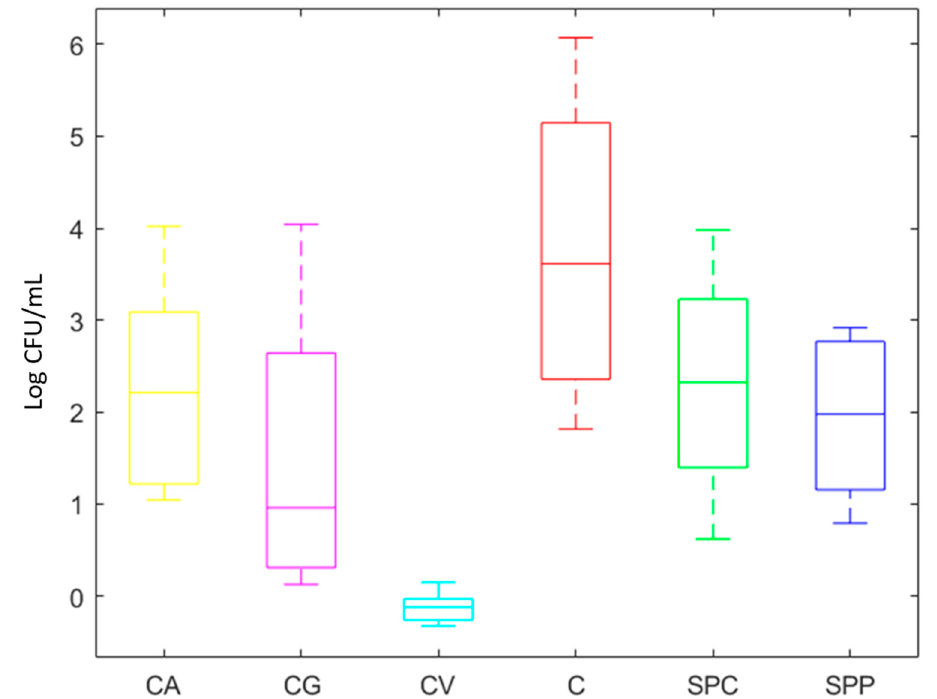
Figure 3. Boxplot representing the increase of viable cell concentration after fermentation in di ff erent tomato-based products. The bottom at the end and at the top of whiskers indicates the smallest and the largest results, respectively. The line in the bar, in each plot, is the Median. The x axis reports the products and y axis reports the microbial count expressed as Log CFU /